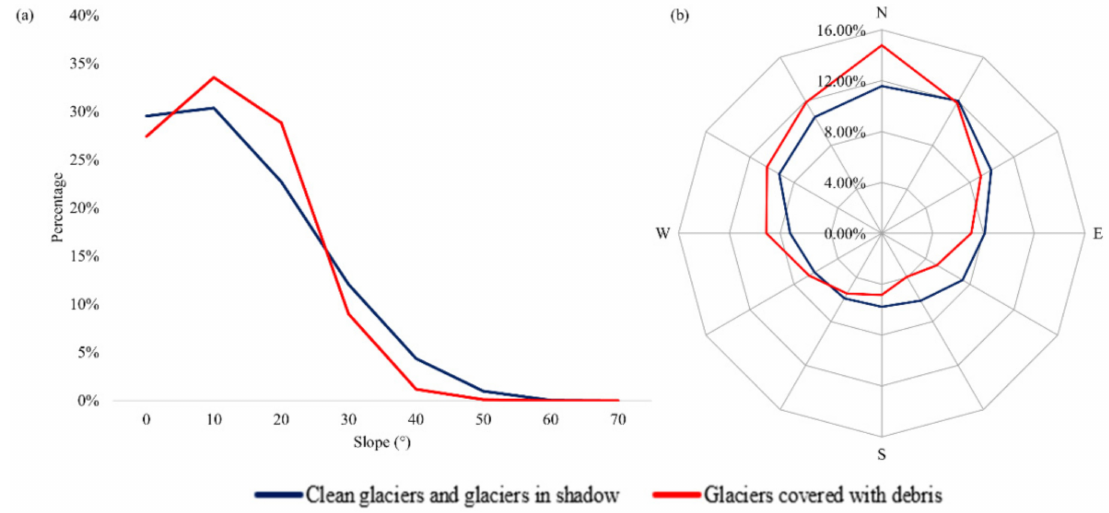
Figure 14. Percentages of the two types of glaciers at different slopes ( a ) and different aspects ( b